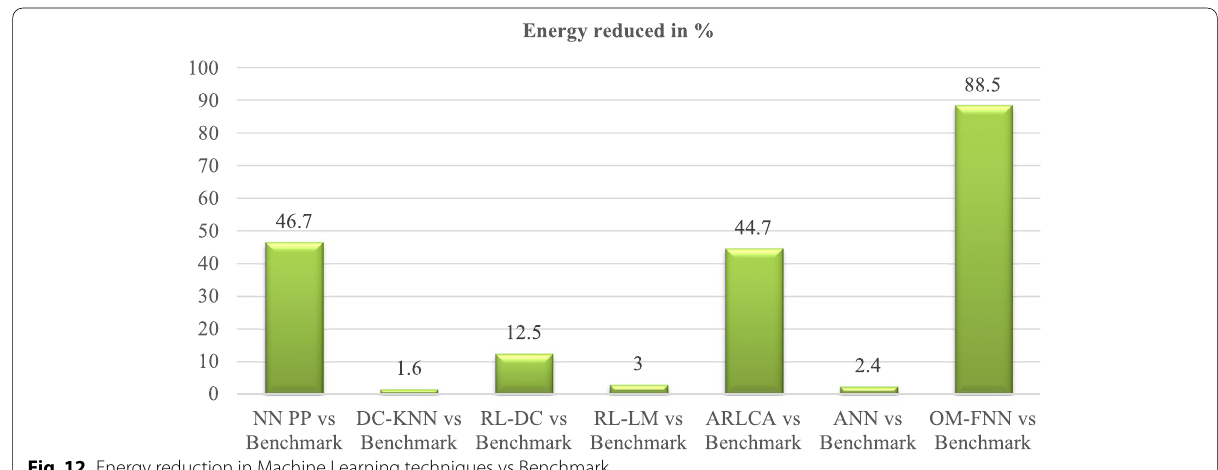
Fig. 12 Energy reduction in Machine Learning techniques vs